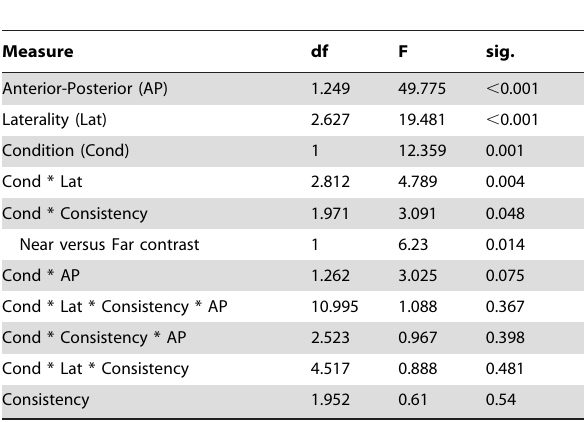
Table 1. ANOVA results for the N1 ERP, with trials binned by trial-to-trial (lag 1) formant Euclidean